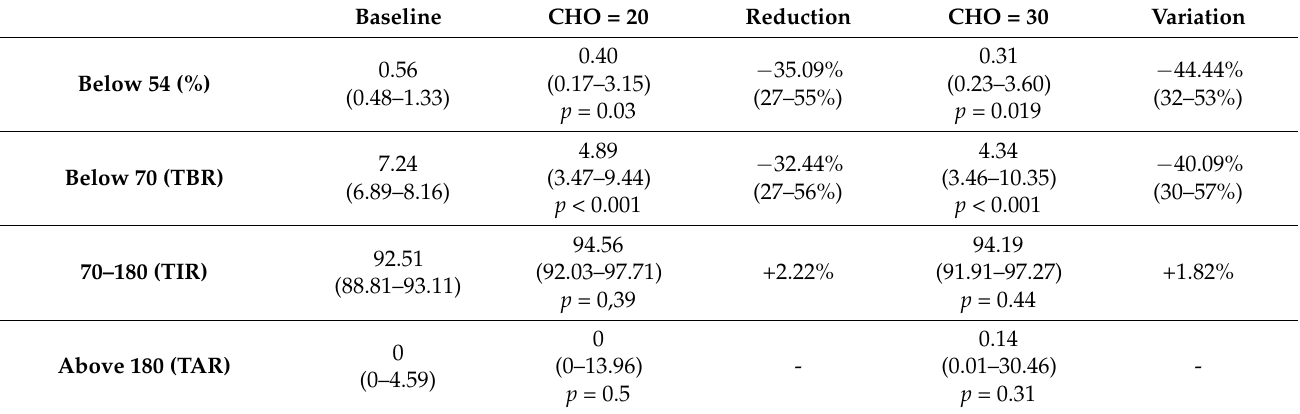
Table 6. Statistical results of the percentage of time in different glycemic intervals ( p -values < 0.05). Each blood glucose level interval is expressed in mg/dL. Abbreviations: TBR, time below range; TIR, time in range; TAR, time above range; NaN, not a